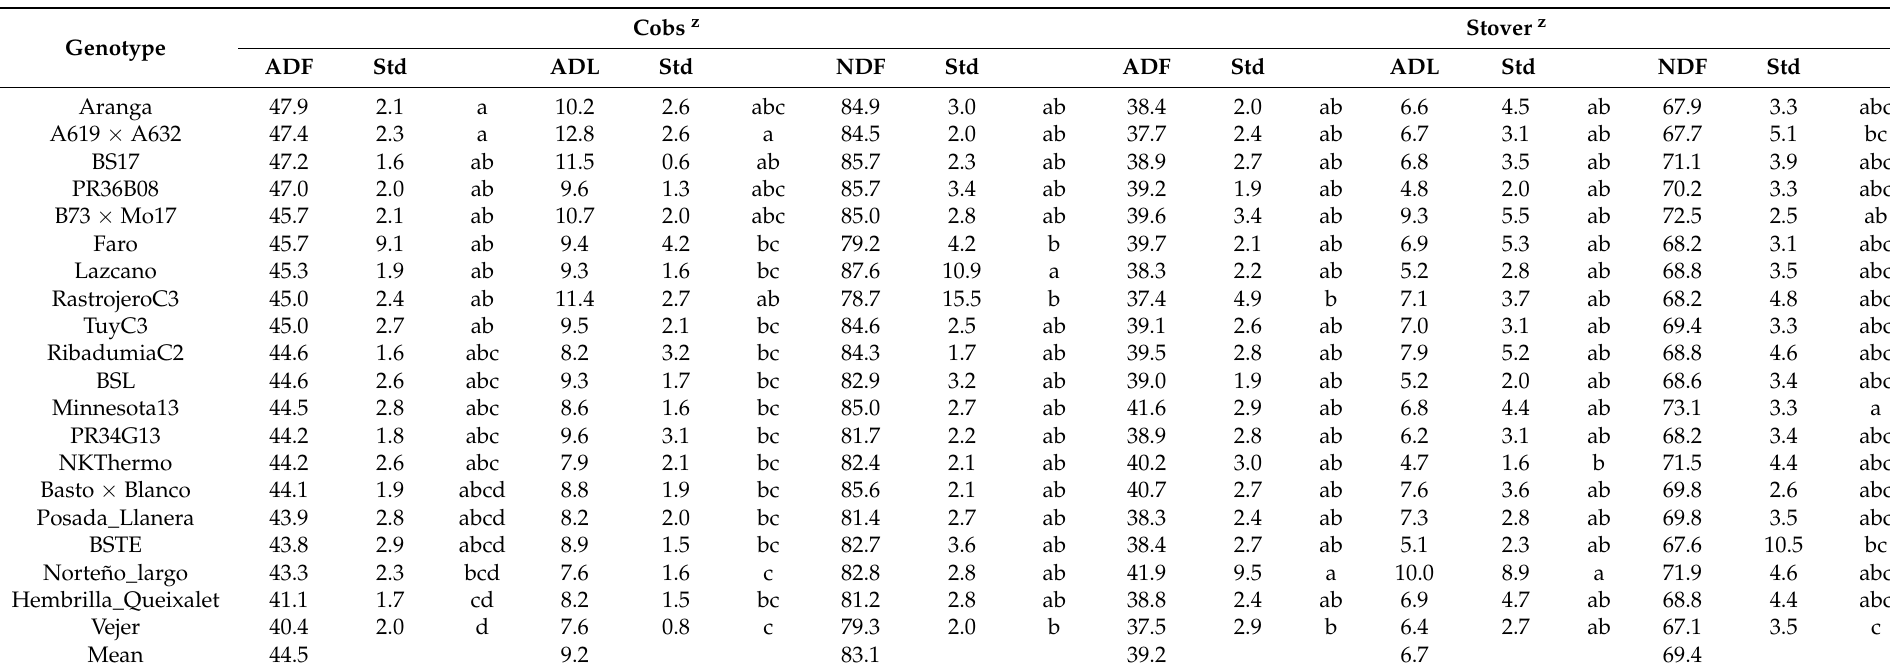
Table 5. Means of fiber components: acid detergent fiber (ADF), acid detergent lignin (ADL), and neutral detergent fiber (NDF) from 20 maize genotypes grown at four environments in Galicia, Spain, in 2010 and 2011. Values ordered based on the cob ADF means. Cobs z Stover z Genotype